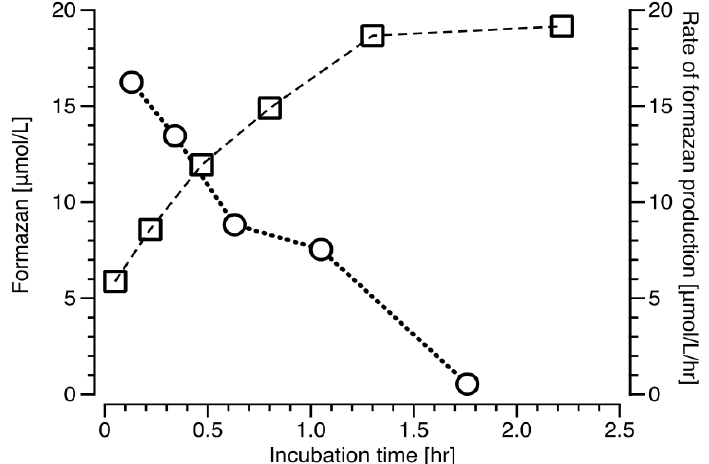
Figure 4. Formazan in V. harveyi batch cultures amended with 0.5 mM INT ( (cid:3) ), and rate of formazan production ( ). (cid:35)